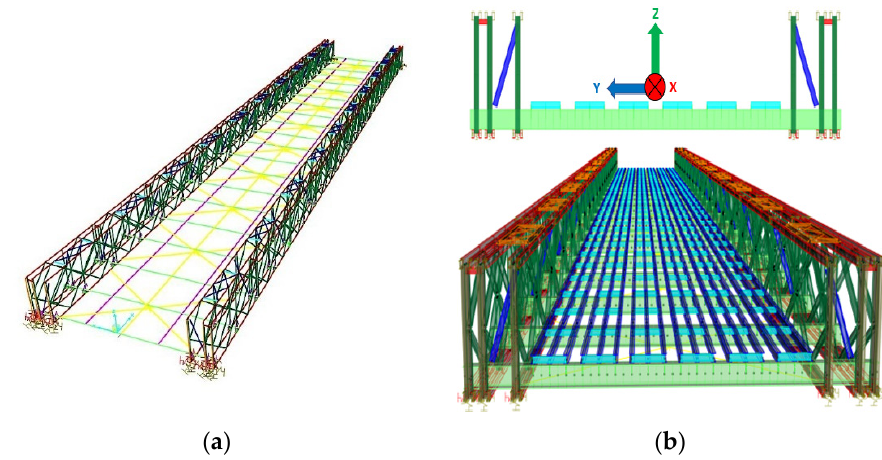
Figure 22. TS Bailey bridge FE model: ( a ) straight frame model; ( b ) 3D visualization. Horizontal and vertical links, which are constrained along the three axes, are used to connect the cross-beams (Figure 23) with the panels. The horizontal bracings were also modeled by links, with a sufficiently large stiffness taken equal to 25 MN/m.